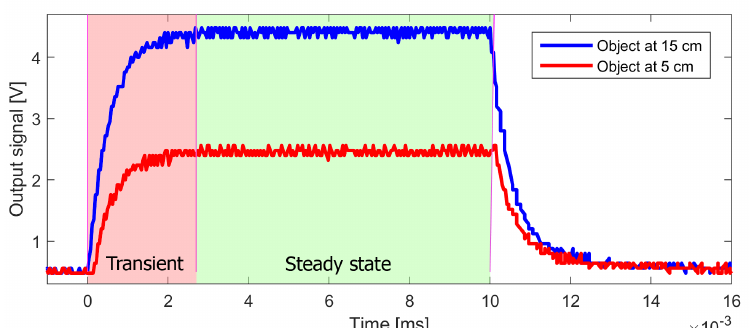
Figure 9. Sensor output response for a single reading.